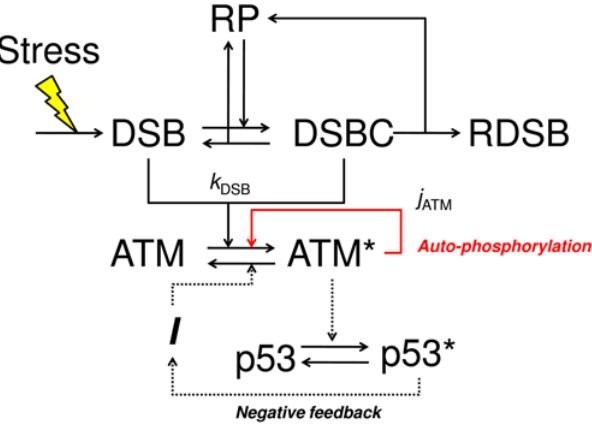
Figure 1. A diagram of the detection mechanism of DSB depending on ATM. Abbreviations – DSB: DNA double-strand break; RP: repair protein; DSBC: DNA double-strand break and repair protein complex; RDSB: repaired DSB. Asterisks denote phosphorylated proteins. I denotes an intermediate repressor of ATM. Some stress signal induces DSBs which are repaired by RPs. ATM detects DSBs and DSBCs, and then it is phosphorylated. The red arrow denotes autophosphorylation of ATM, which amplifies the stress signal. The dotted arrows denote a negative feedback loop. We mainly address DSB repair processes and the ATM sensor module. We refer to the effect of the negative feedback from p53 only in the Discussion section. Details are shown in the main